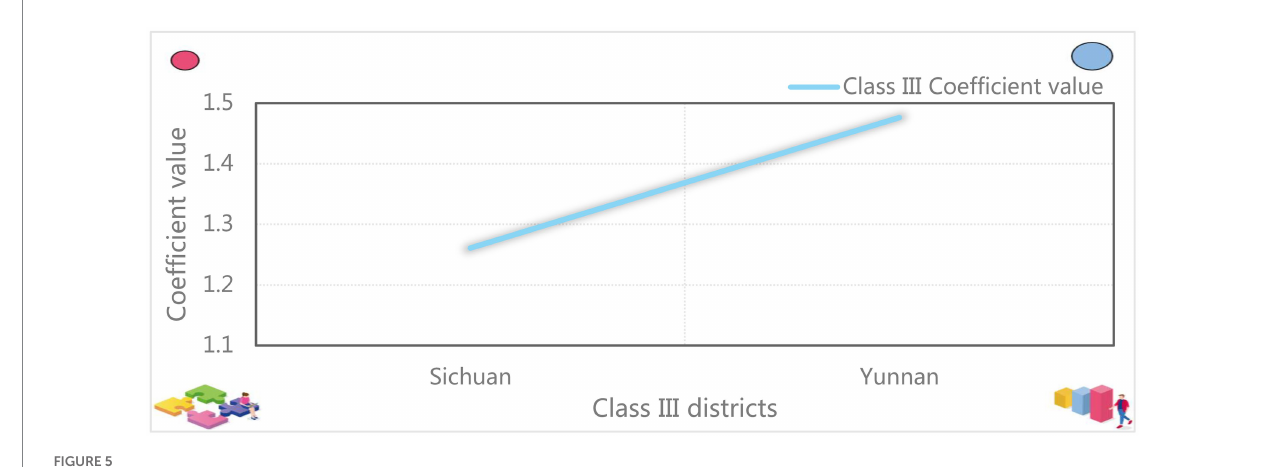
TABLE 5 Johansen cointegration test results for various regions. Area